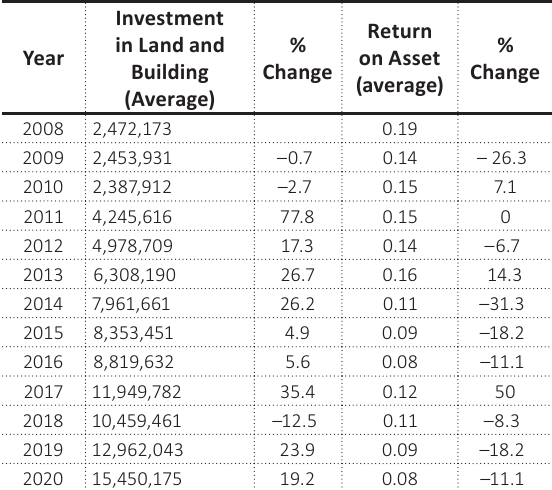
Table 1. Changes in investment in